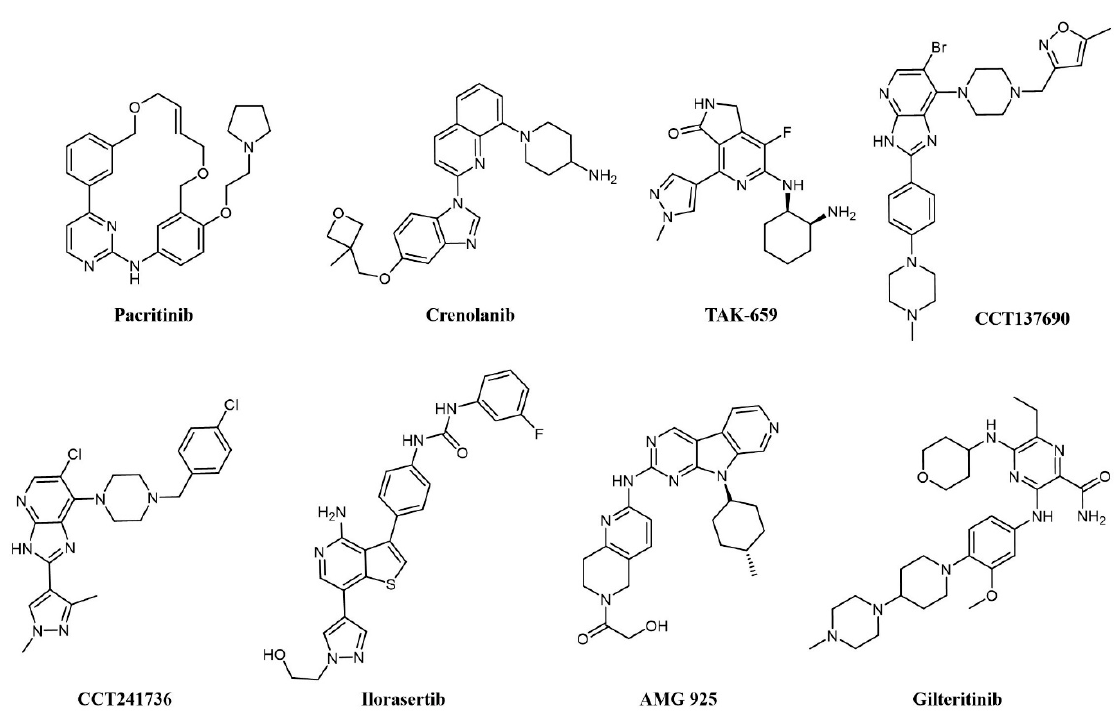
Figure 5. Chemical structure of multi-target fms-like tyrosine kinase 3 (FLT3) inhibitors used for AML treatment.